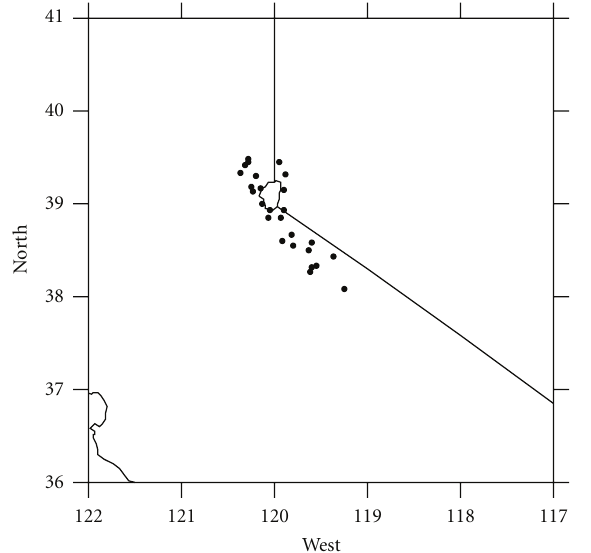
Figure 1: 26 Snotel Stations located in the California and Nevada areas.